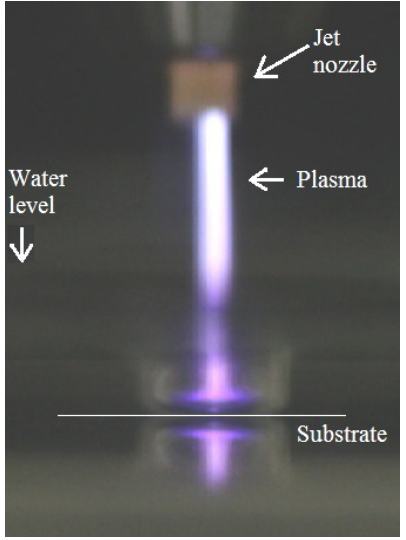
Figure 2: Photograph during film deposition by the APPJ in contact with